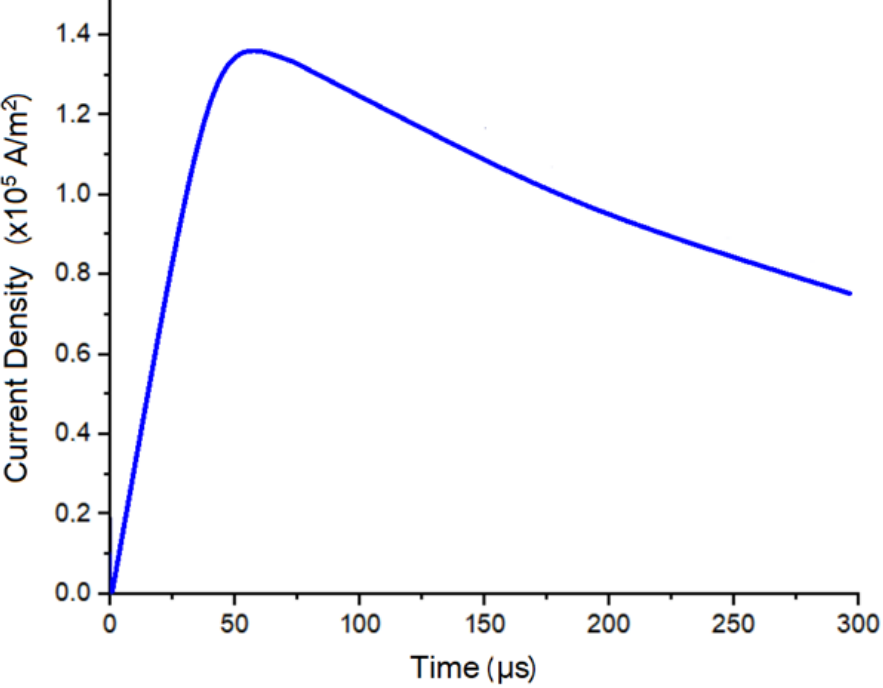
Figure 12. Conceptual blade design including standard and add-on LPS – GRP.